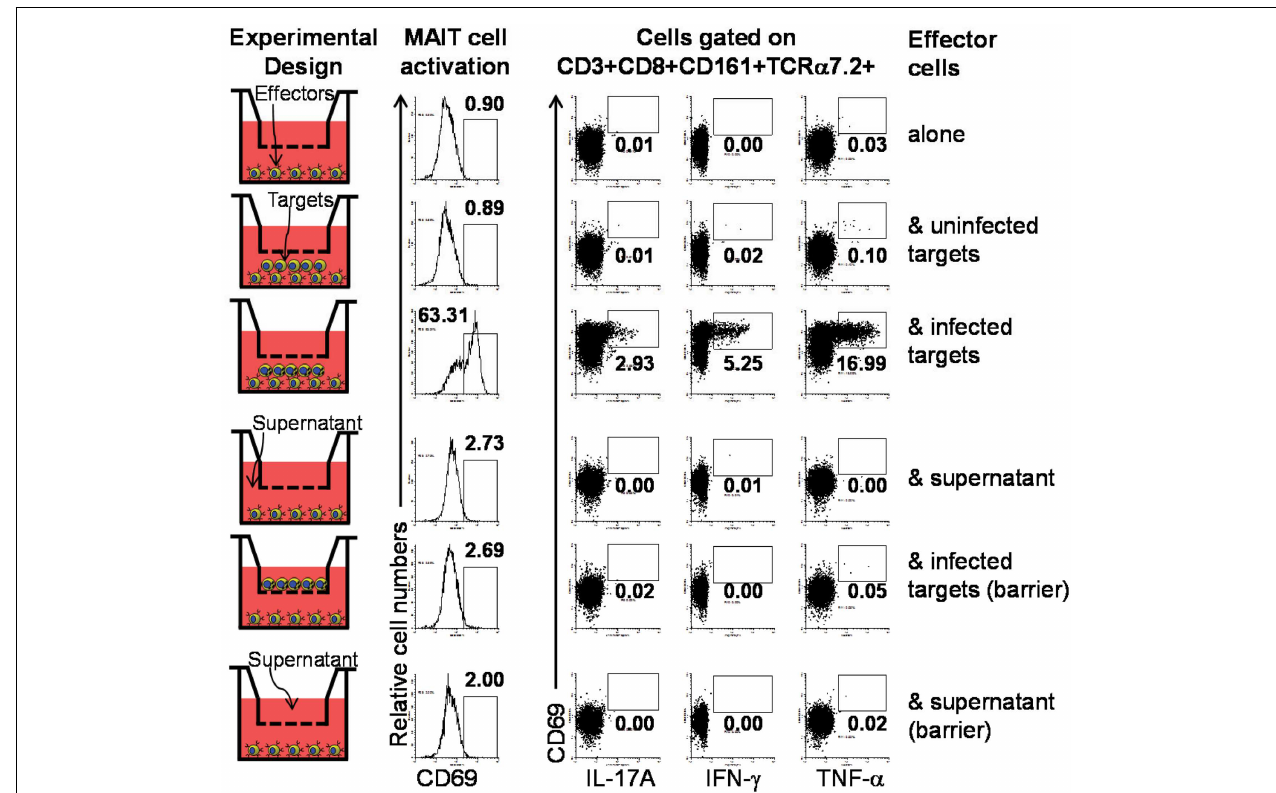
(0.4 µ m). Supernatants from infected-target cell culture that were cleared by centrifugation were used as control for microbial product effect. Human ex vivo PBMC were exposed for 16–18h to B-LCL targets and activation and cytokine production by MAIT cells were evaluated by flow cytometry. Data are representative of two